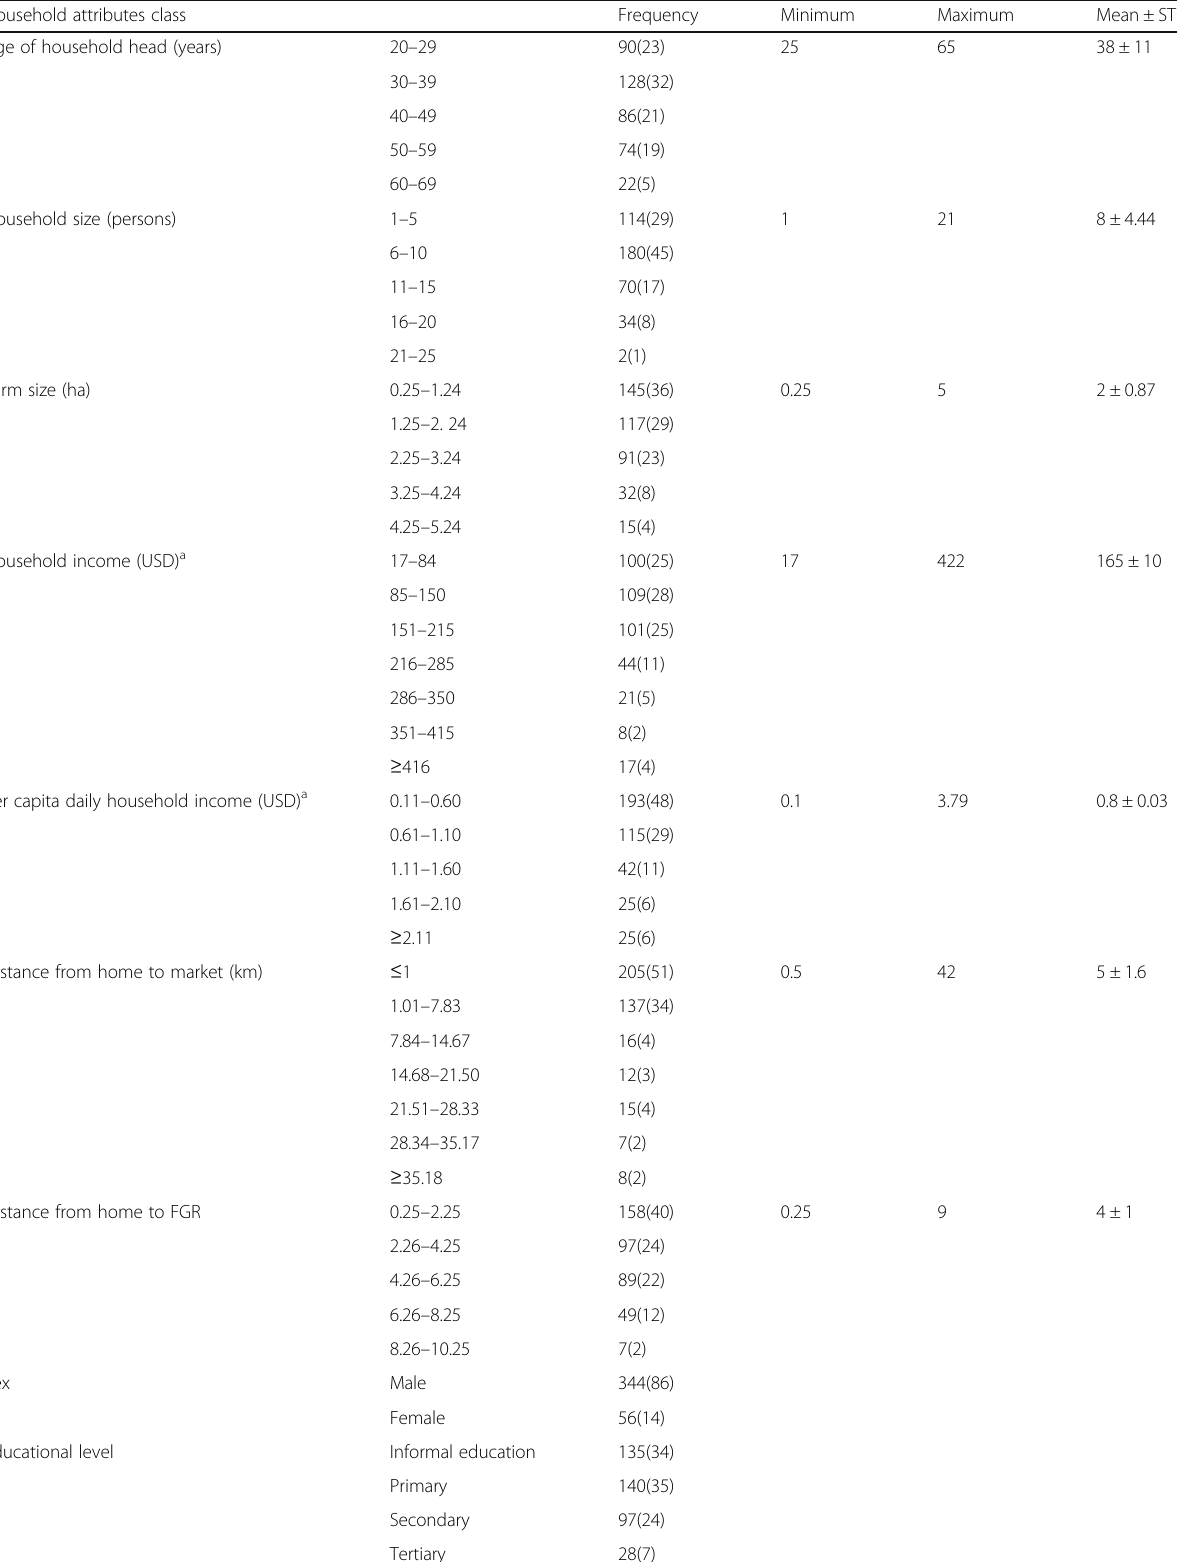
Table 2 Socioeconomic attributes of the